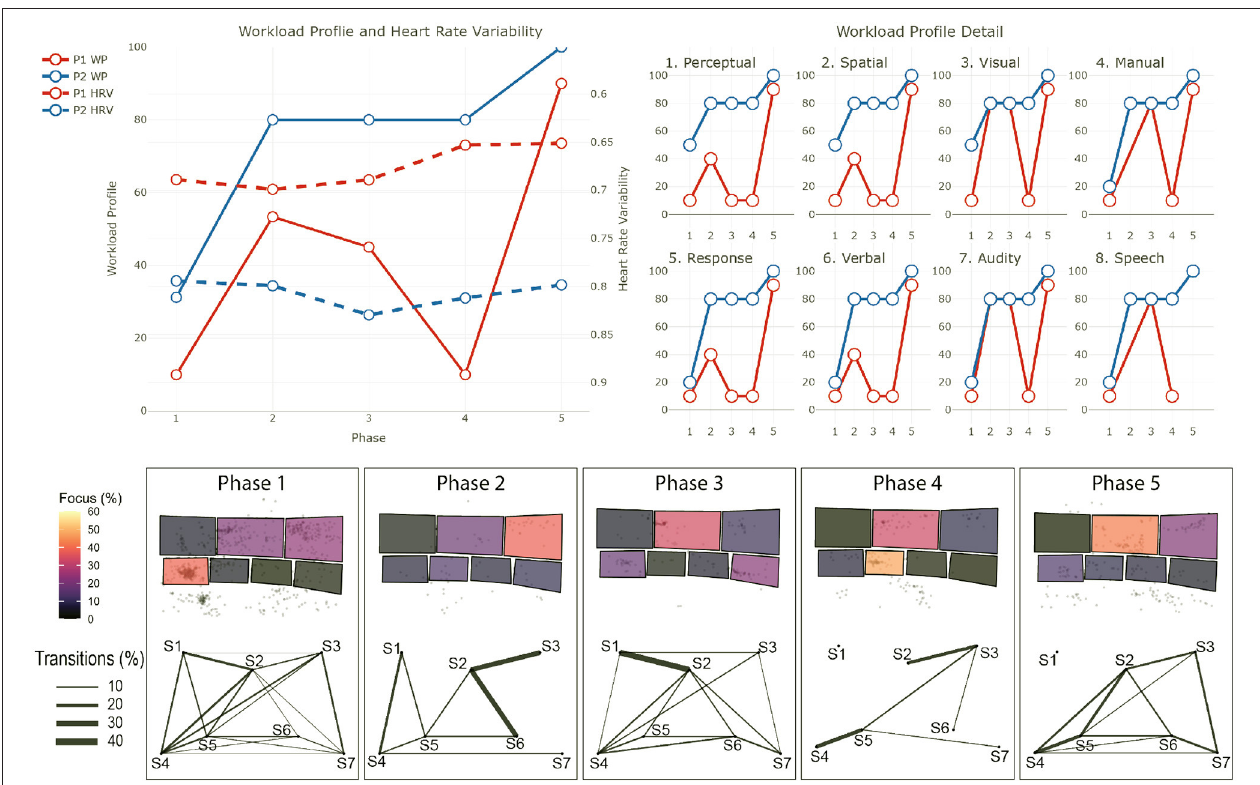
FIGURE 6 | Results for the first session of training 3. The top-left chart shows the evolution of the WP and HRV during the session for both participants (the axis of the HRV is inverted). The top-right chart shows the evolution of each criteria of the WP during the session for both participants. The bottom chart displays eye tracking data for P2 for each phase: at the top is the schematic representation of the operator’s workspace with a heatmap showing the amount of time the operator spent focusing on each screen; the bottom graph indicates the amount of transition between each of the screens with the thickness of the lines. The same organization is used in the following